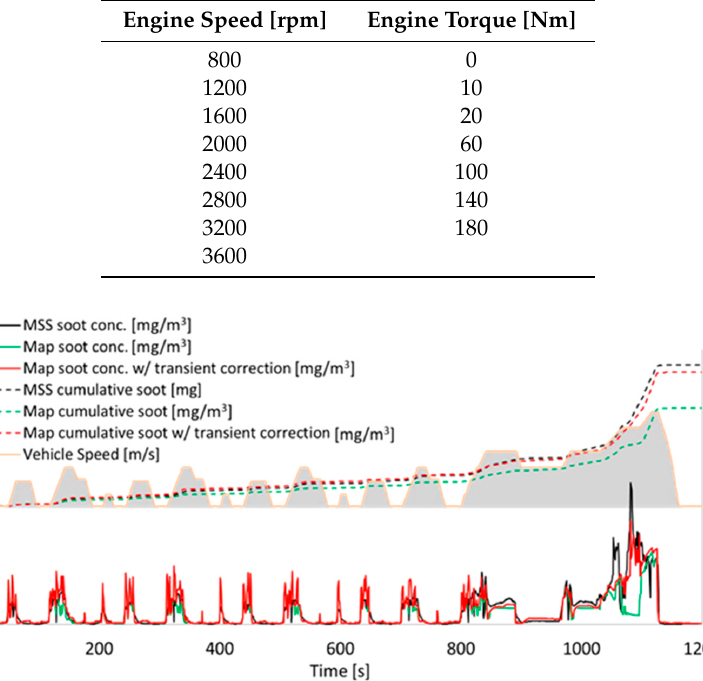
Table 3. Operating point levels for the development of the soot model.